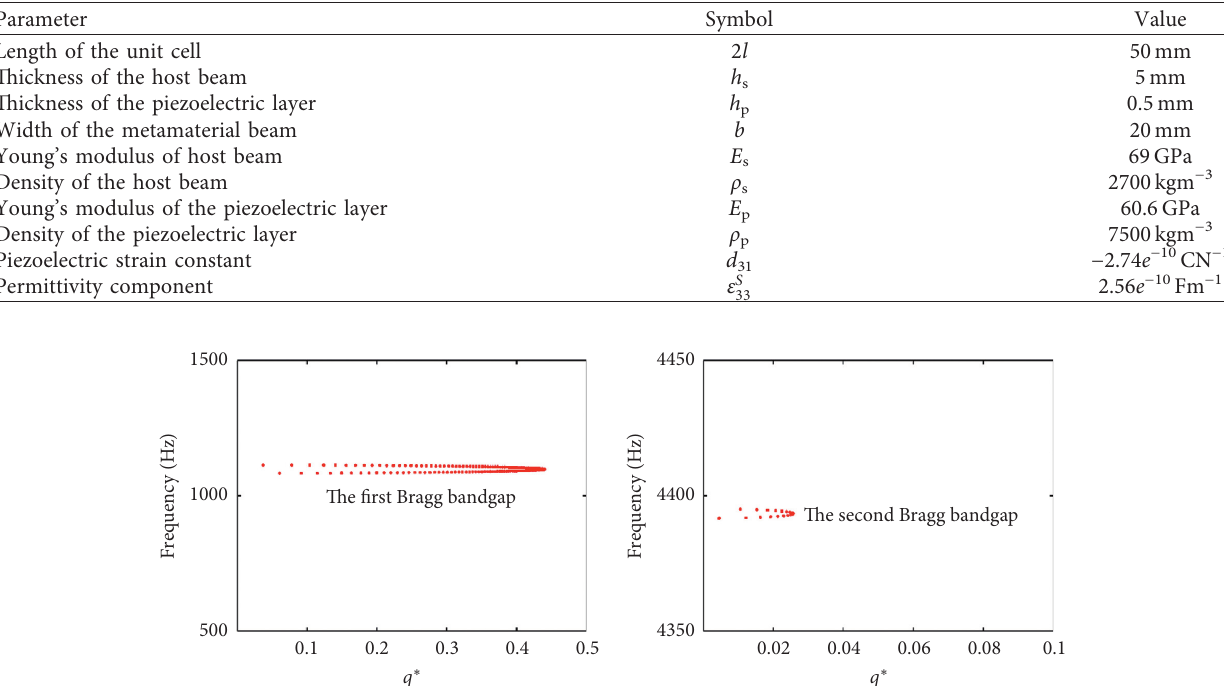
� 10 − 6 Ω and R � 10 6 Ω : (a) the first Bragg bandgap and 1 2